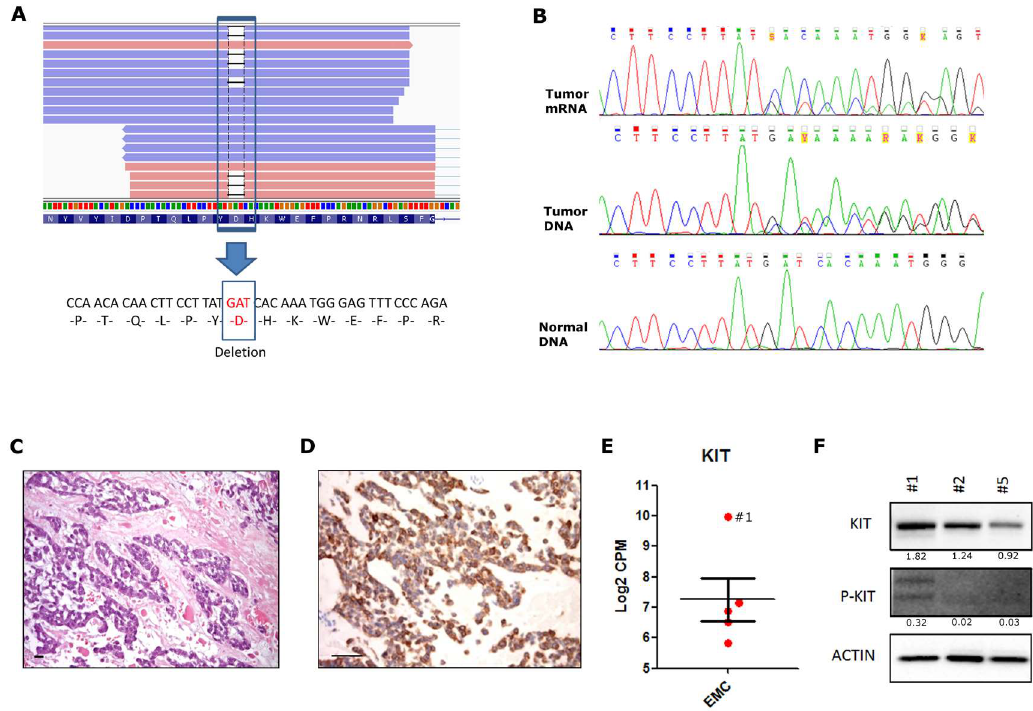
Figure 2. Identification of a KIT exon 11 deletion in one case of EMC. ( A ) WTS reads supporting the deletion. Blue and pink bars represented the reads (respectively sense and antisense to the reference). Black lines that interrupt the alignment of the reads represent the deletion of three bases, corresponding to p.D579del. ( B ) Sanger sequencing validation of the mutation at mRNA and DNA level (upper and lower panel). In tumor specimens, the overlapping of two signals, starting after the TAT codon, demonstrated the presence of the heterozygous deletion corresponding to p.D579del. ( C ) Hematoxylin and eosin stain, and ( D ) immunohistochemistry evaluation of KIT in Sample #1. Scale-bars indicate 50 μm ( E ) Expression level of KIT mRNA was evaluated through counts per million (CPM) analysis from WTS data. Each red circle correspond to one of the five EMC case analyzed: sample #1 is indicated. ( F ) Detection of KIT protein expression and phosphorylation through western blot on three EMC cases. Relative quantification of band intensity is shown under each blot. Actin was used as the loading control.